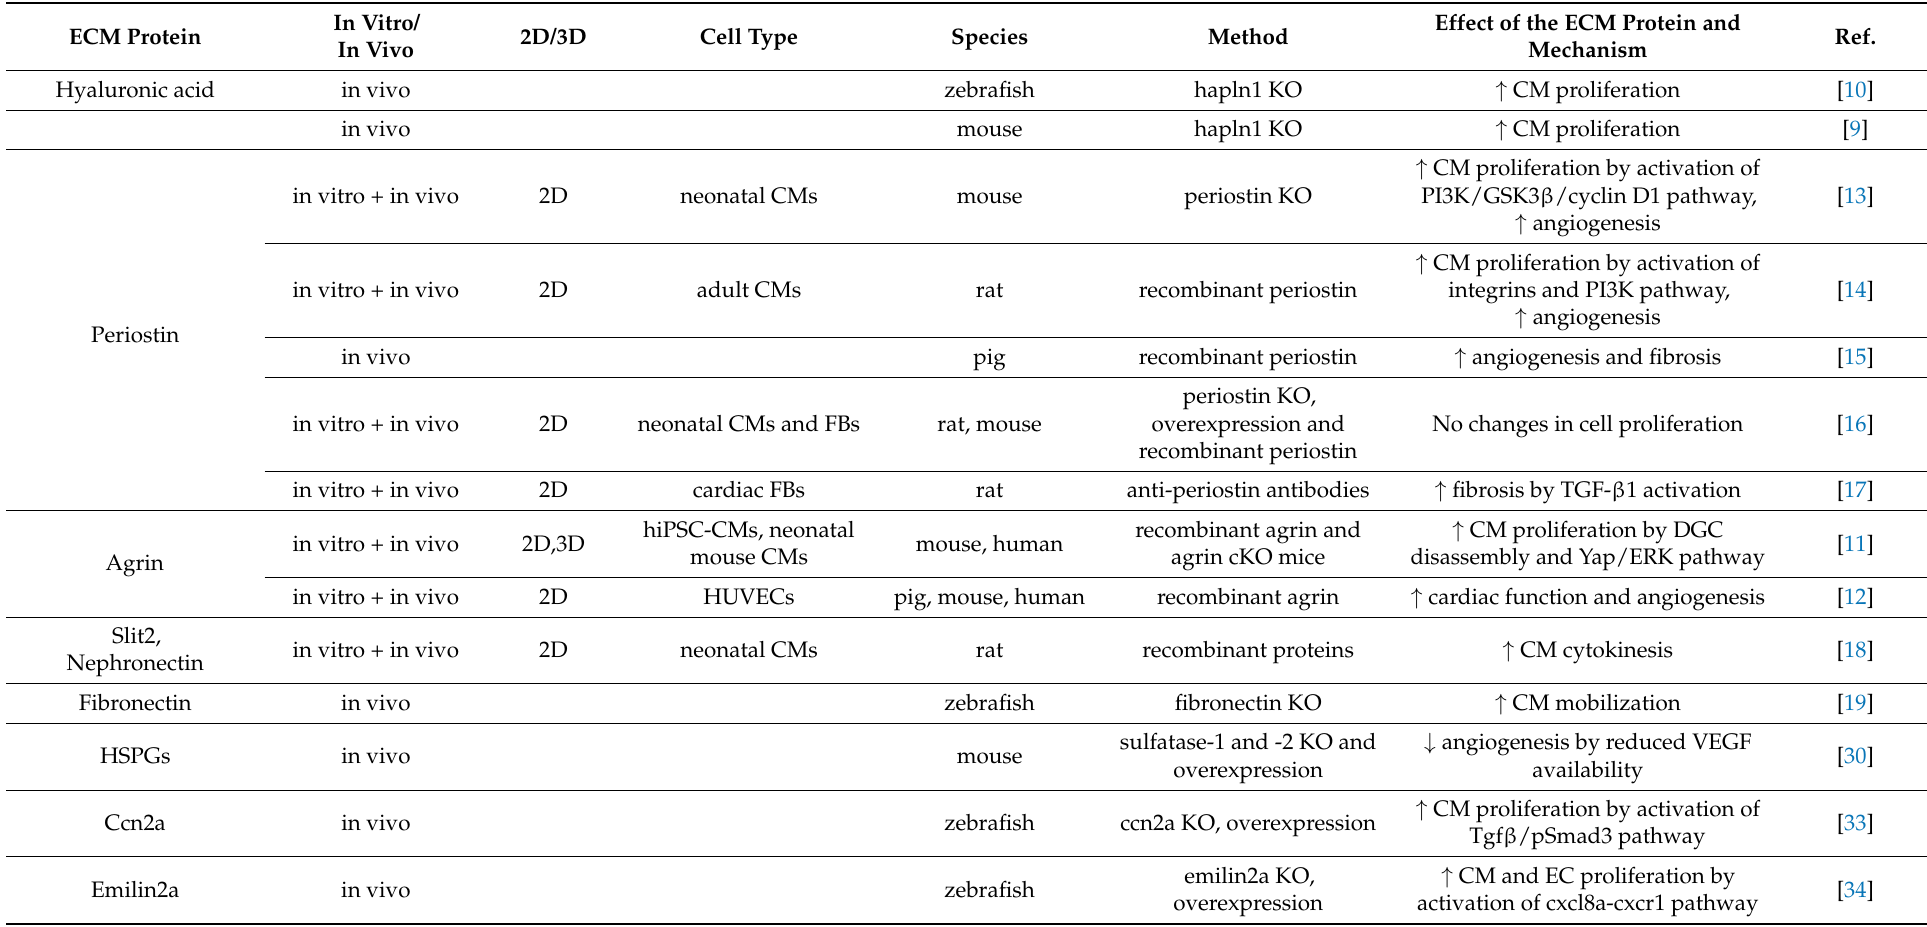
Table 1. ECM proteins described to have a pro-regenerative effect in the